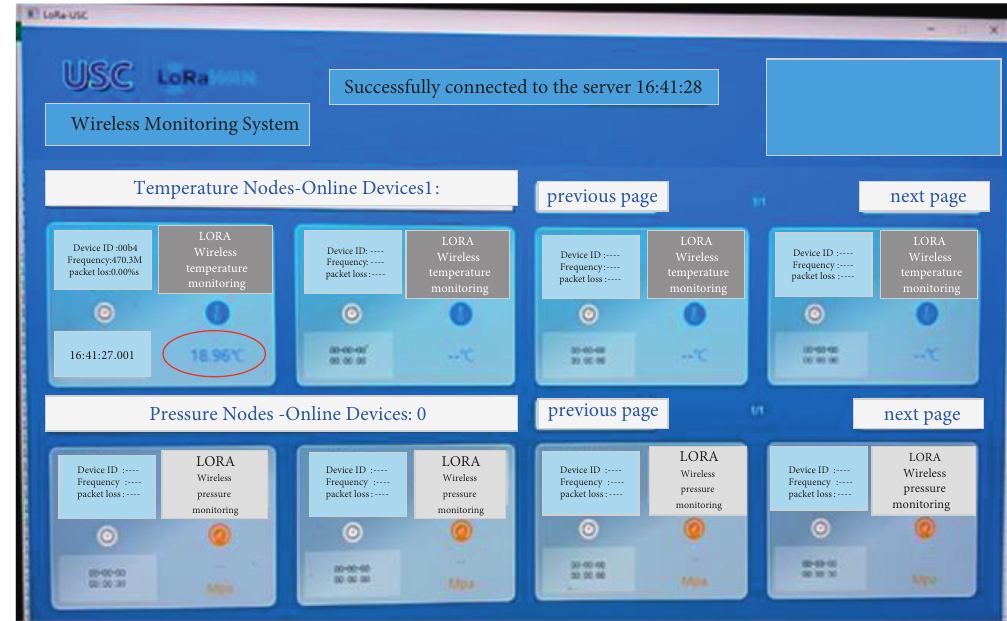
Figure 19: Wireless temperature sensor value display at S7 on the first level of the bench.